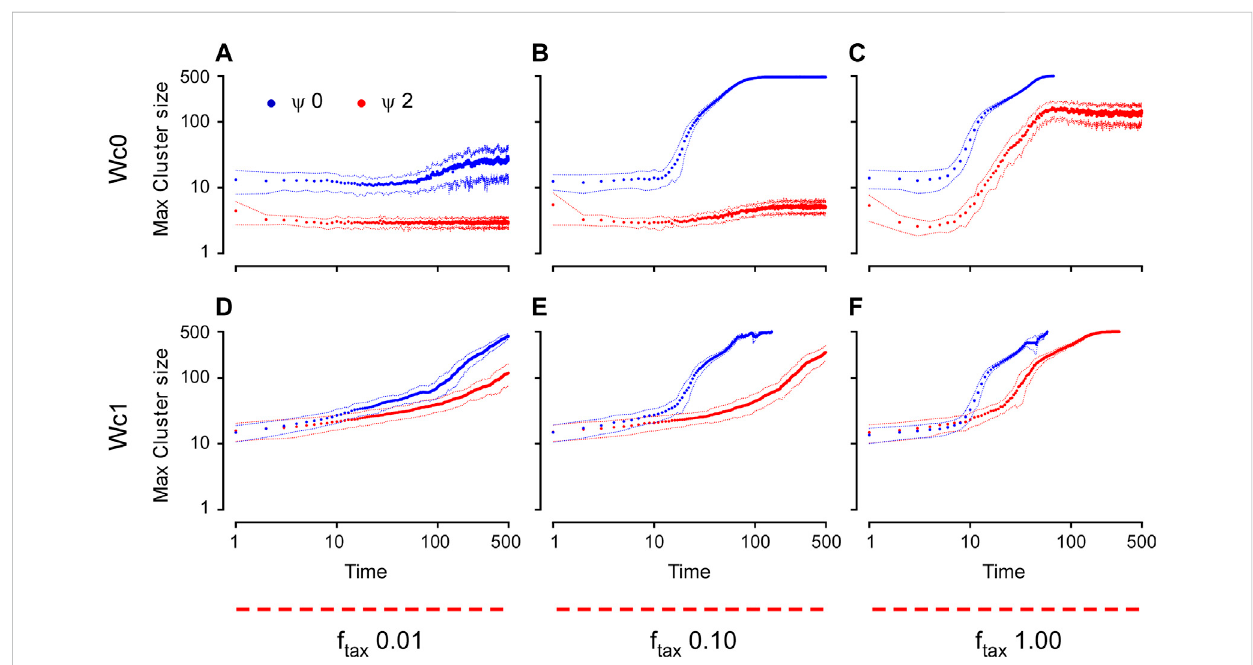
FIGURE 7 Time dynamics of aggregation for the environmental guidance model measured by the maximum cluster size. The cluster size is plotted here as a function of time for different W c [(0 for (A – C) and 1 for (D – F) ], different f tax (0.01, 0.1, and 1 for the fi rst, second, and third column, respectively), and for twodifferentvaluesof ψ (0forthebluecircles, and2fortheredones).Thedatapointsaretheaveragefrom50differentsimulations,andthedashedlines representthestandarddeviation.Theconditionsusedaccuratelyrepresentthe invivo densityofthecells( ϕ (cid:1) 0 . 2,500cellsonasphereofradius25). All plots are generated using a logarithmic scale. The simulations were stopped when they reached a single aggregate (maximum cluster size of exactly 500 cells). Hence, the one cluster condition is only reached in those simulations that are interrupted at an earlier time [i.e., ψ = 0 in (C, E) ; ψ = 2 in (F) , whereas for ψ = 0 in (B) , the curve gets very close but never reaches the single cluster